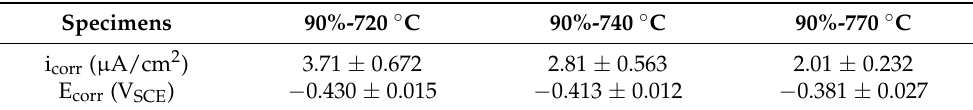
Table 4. i corr , E corr values of specimens at 90% deformation with different annealing temperatures derived from the potentiodynamic